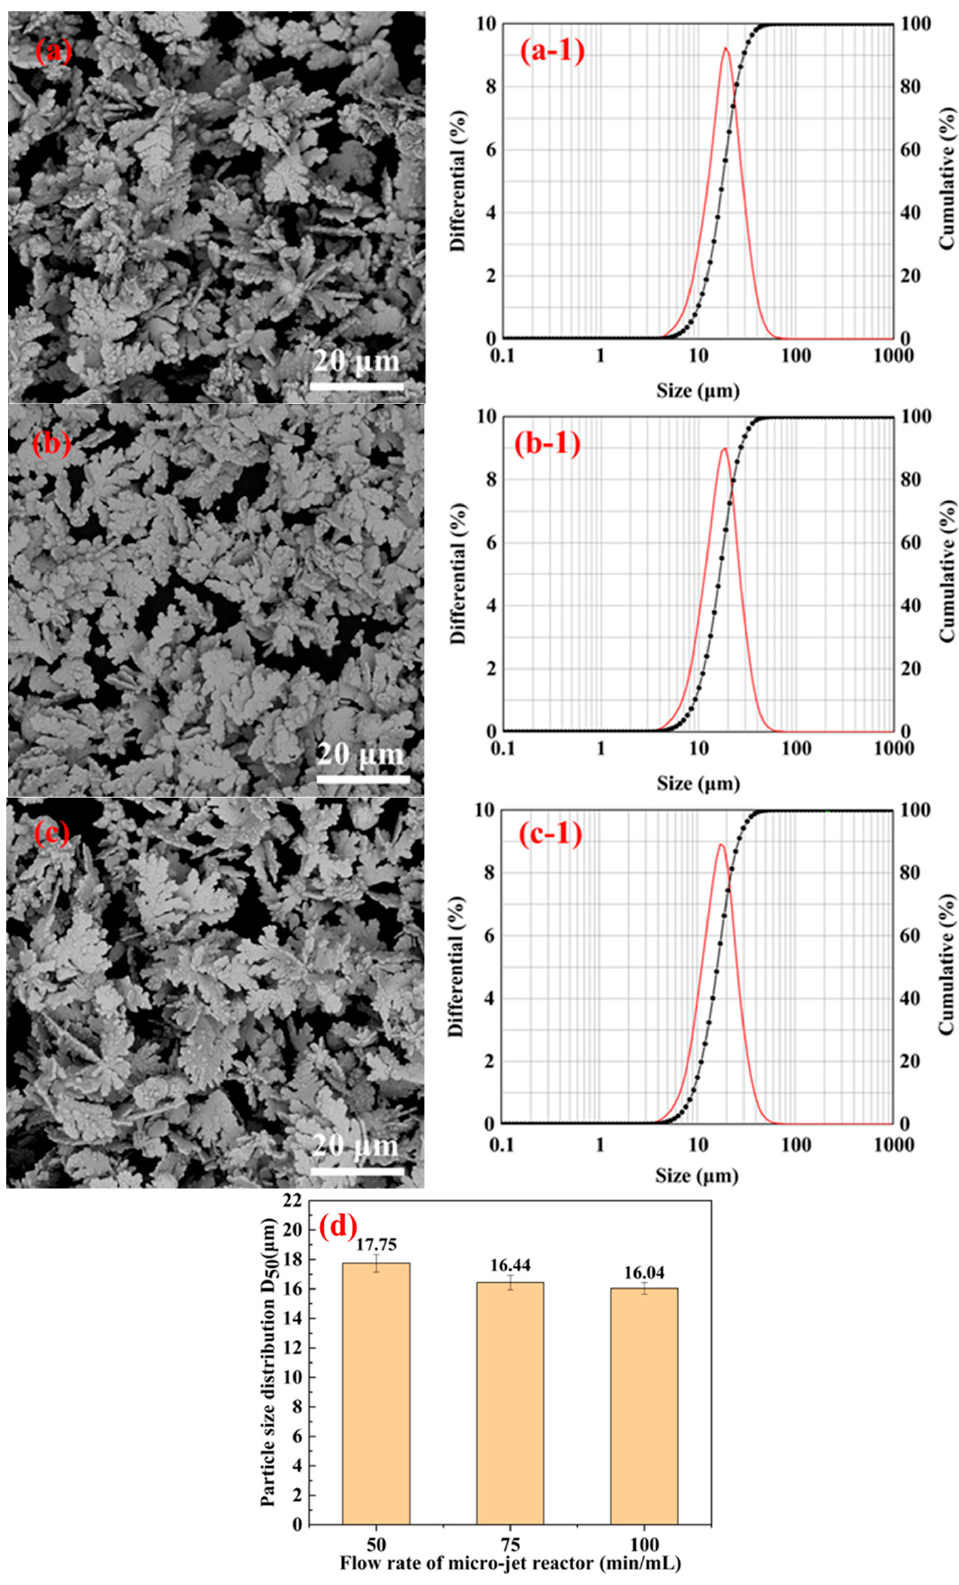
Figure 10. SEM images, particle size distribution, and D 50 distribution of silver powders prepared under different jet flow rates by adding 2% gelatin. ( a ) 50 mL/min; ( b ) 75 mL/min; ( c ) 100 mL/min; and ( d ) D 50 distribution of silver powder.